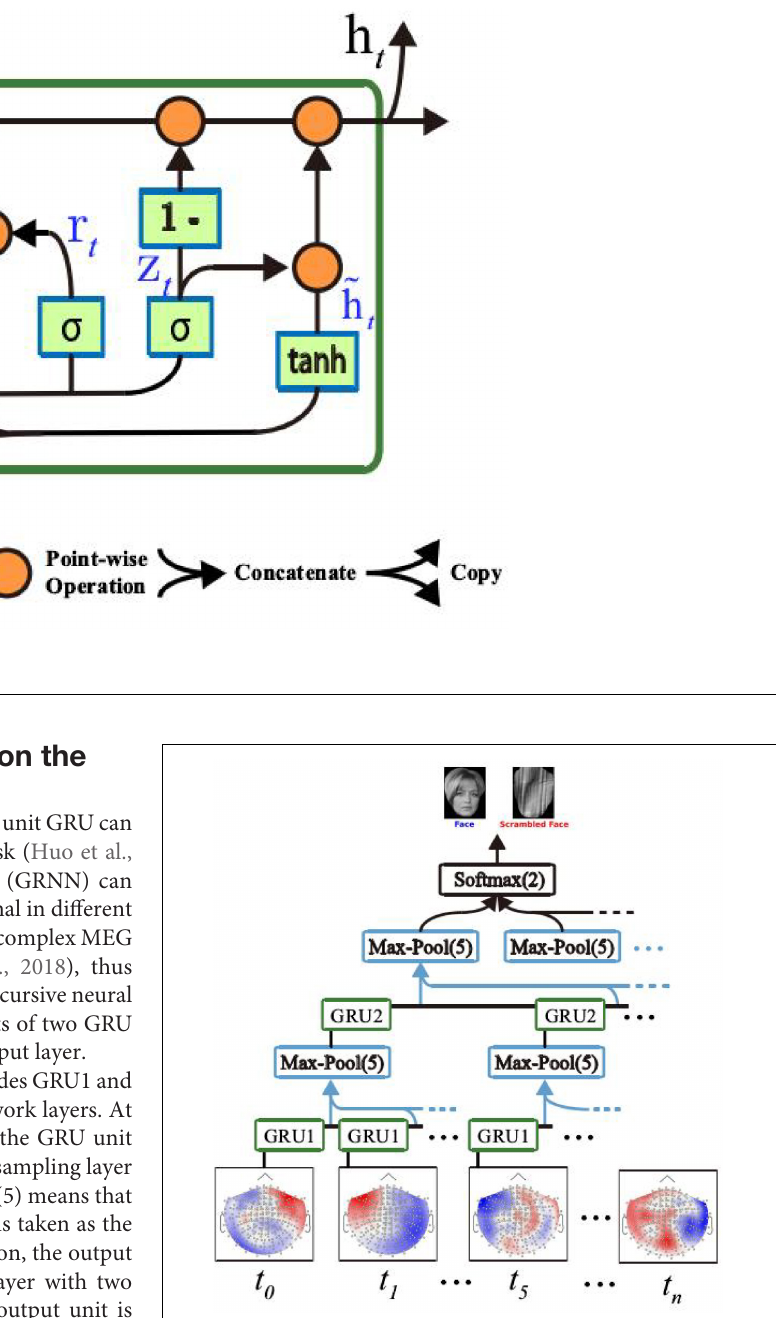
where c = 1 represents the MEG signal induced by a face image, and c = 2, the MEG signal stimulated by a non-face image. p 1 represents the probability of the GRNN model detecting a face- prompted MEG signal, and p 2 , the probability that a MEG signal induced by non-face images is detected.